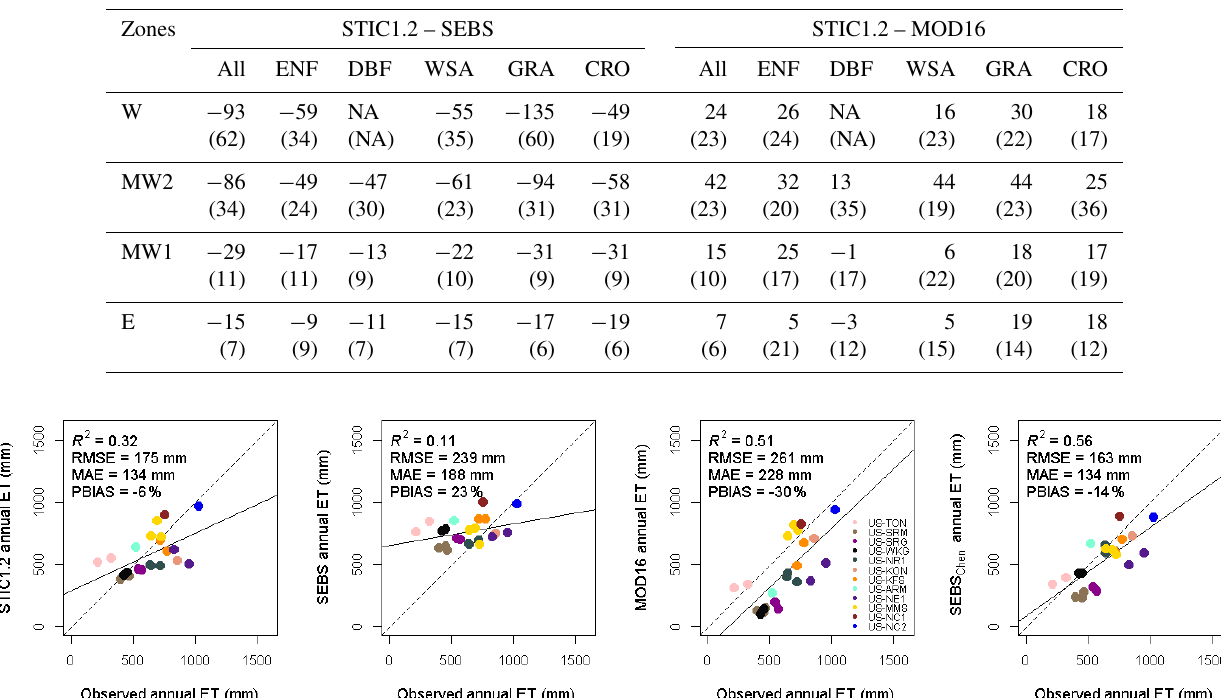
Figure 12. Comparison of annual ET from STIC1.2, SEBS, MOD16, and SEBS Chen against observed annual ET from the core AmeriFlux sites. Missing daily observed ET at the flux sites were filled using linear interpolation between available days. Missing 8-day cumulative ET from STIC1.2 and SEBS were filled using the constant evaporative fraction (EF) approach. Annual ET from the models and flux sites are compared when at least 38 (out of 46) 8-day cumulative ET were available for computation of annual ET and at least 300 days of observed λE were available at the flux tower sites. SEBS Chen is a recently developed global monthly SEBS ET product based on improved kB − 1 parameterization outlined in Chen et al.